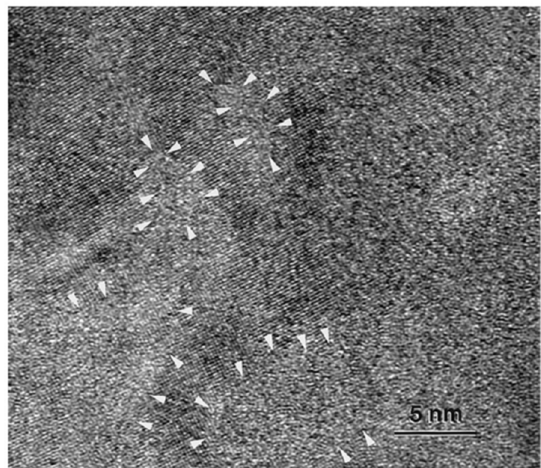
Figure 2. High ‐ resolution transmission electron microscopy image of a rapidly solidified Al ‐ 4V ‐ Figure 2. High-resolution transmission electron microscopy image of a rapidly solidified Al-4V-2Fe 2Fe alloy. Amorphous regions surrounded by the interconnected α‐ Al phase are arrowed. Re ‐ alloy. Amorphous regions surrounded by the interconnected α -Al phase are arrowed. Reprinted printed from [38], Copyright (1998), with permission from Elsevier. from [38], Copyright (1998), with permission from